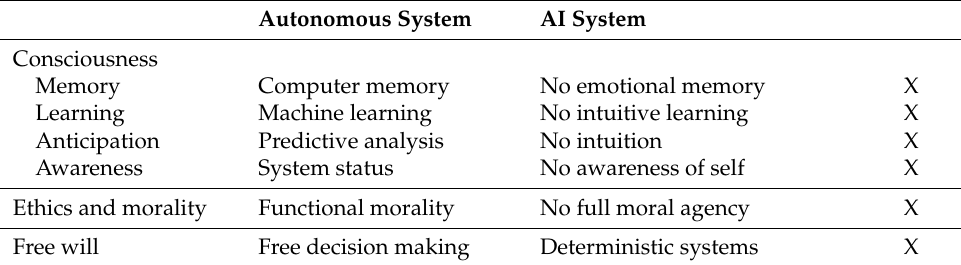
Table 2. Requirements for autonomous systems and the comparison to current AI